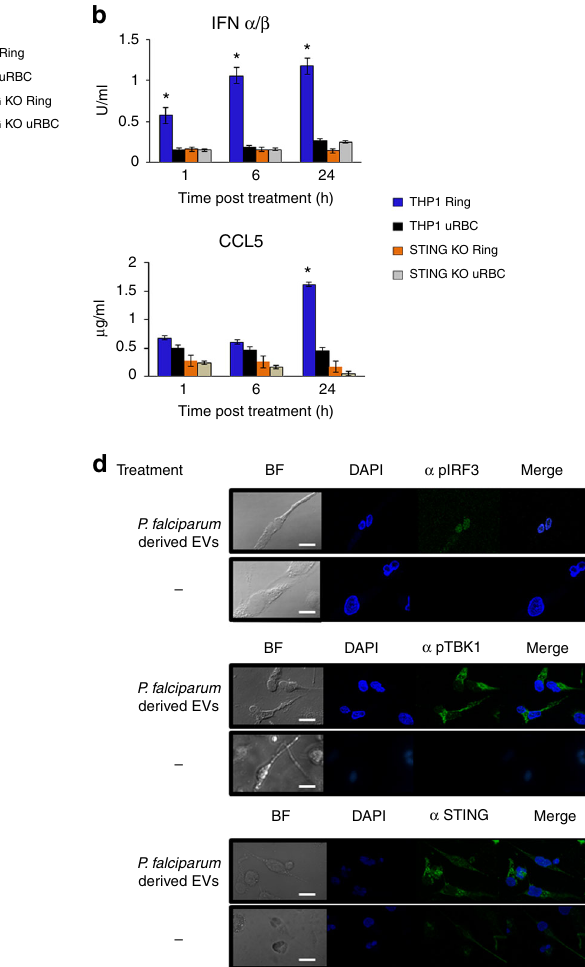
Fig. 8 P. falciparum EV-DNA activates STING-dependent signaling in monocytes. a . THP-1 or STING KO THP-1 cells were incubated with P. falciparum ring- stage-derived or uRBC-derived vesicles for 1, 6 and 24 h. RT – PCR was performed for IFNA , IFNB , CXCL10 , IFIT1 and CCL5 . SD and T -test analysis * p ≤ 0.05. b . THP-1 or STING KO THP-1 cells were incubated with P. falciparum ring-stage or uRBC-derived vesicles for 1, 6 and 24 h. An ELISA assay was performed for CCL5 and CXCL10. HEK blue IFN α / β was performed. SD and T -test analysis * p ≤ 0.05. c . THP-1 cells were incubated with P. falciparum ring-stage-derived vesicles, P. falciparum gDNA or transfected with poly(dA:dT) for 24 h. WB analysis was performed for STING, pIRF3, pTBK1 and α actin, sm-size marker. d . THP-1 cells were incubated with P. falciparum ring stage-derived vesicles for 24 h. Confocal microscopy images were taken for STING, pIRF3, pTBK1 (FITC), and DAPI. Scale bar 10 μ collected from uRBCs (Fig. 8a, black bars). Similar results were obtained when CCL5 or type I IFN production from control and STING KO THP-1s were measured (Fig. 8b, blue vs orange bars). Together, these fi ndings indicate that STING plays a key role in type I IFN response to transferred P. falciparum DNA.